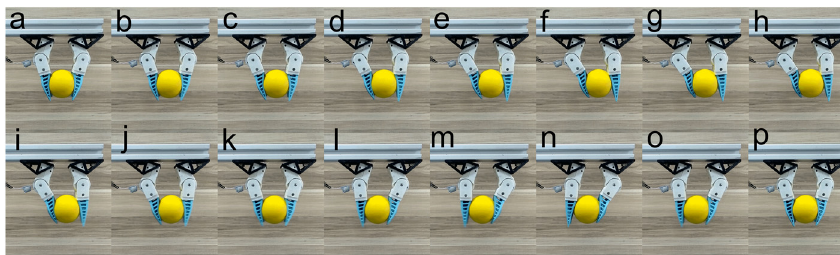
Figure 8. Motion sequences of a double hand operating a ball.